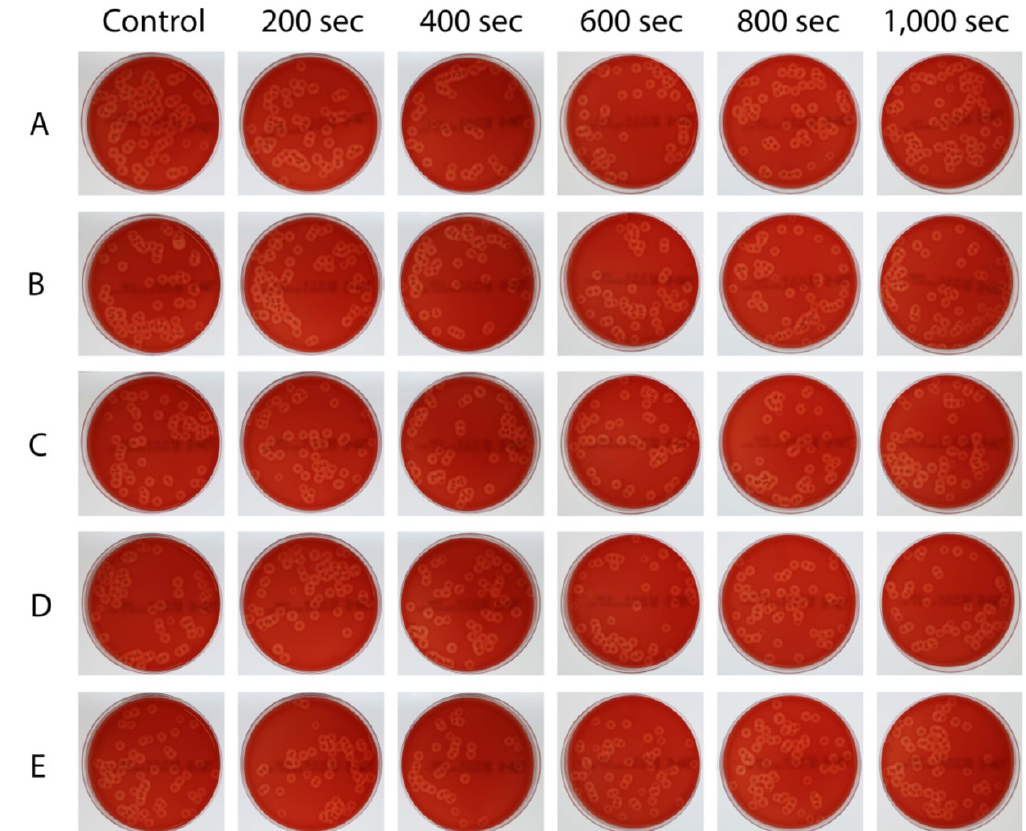
Figure 3. Overview of study results. Individual petri dishes with colonies for the five different light exposure times as well as the unexposed control are shown for measurement series A to